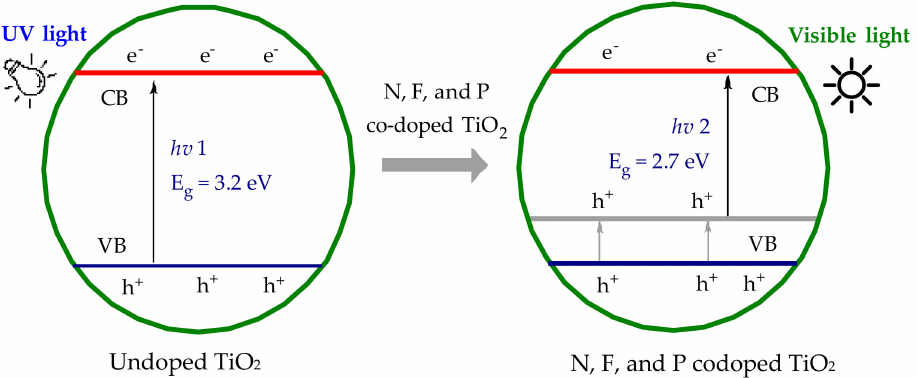
Figure 1. Schematic band gap energy levels of doped and undoped TiO 2 ; E g stands for the band energy gap between the valance band (VB) and conduction band